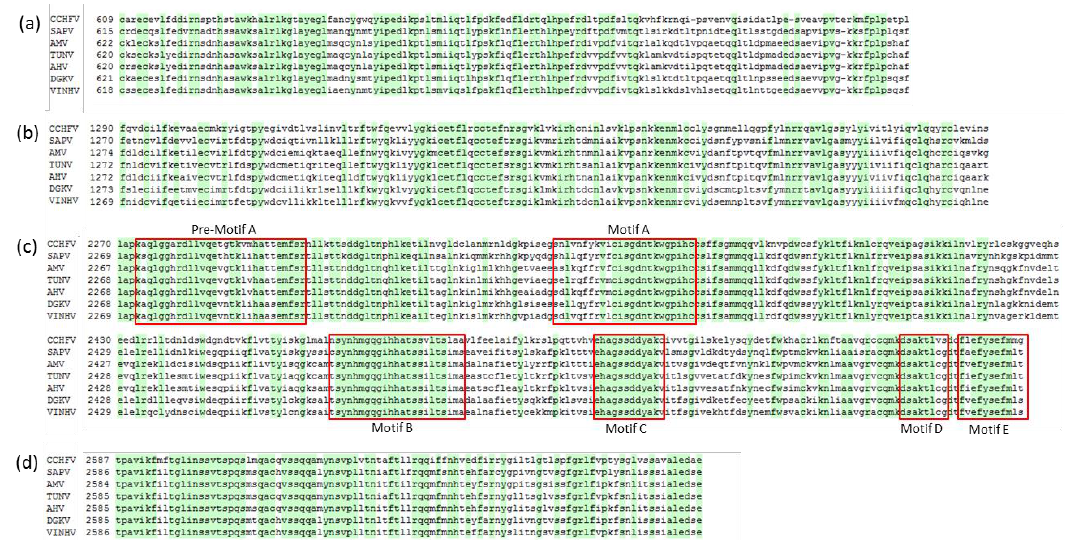
Figure 1. Conserved motifs on Vinegar Hill virus (VINHV) L protein. Amino acid sequence alignments of RNA-dependent RNA polymerase modules of VINHV and other Dera Ghazi Khan group viruses, with Crimean Congo haemorrhagic virus included as a reference. ( a ) Region I and ( b ) Region II are highly conserved in bunya- and arenaviruses; ( c ) Region III, including pre-motif A and motifs A–E, is highly conserved in negative sense RNA viruses, and ( d ) Region IV is highly conserved in bunyaviruses and other segmented negative sense RNA viruses. Conserved amino acid residues amongst the DGK group of viruses and CCHFV are shaded green.